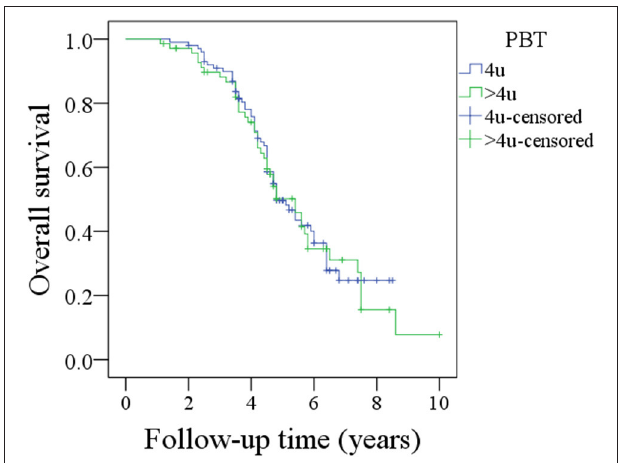
FIGURE 3 | Comparison of overall survival between patients with 4 units perioperative blood transfusion (PBT) and patients with > 4 units PBT ( p =